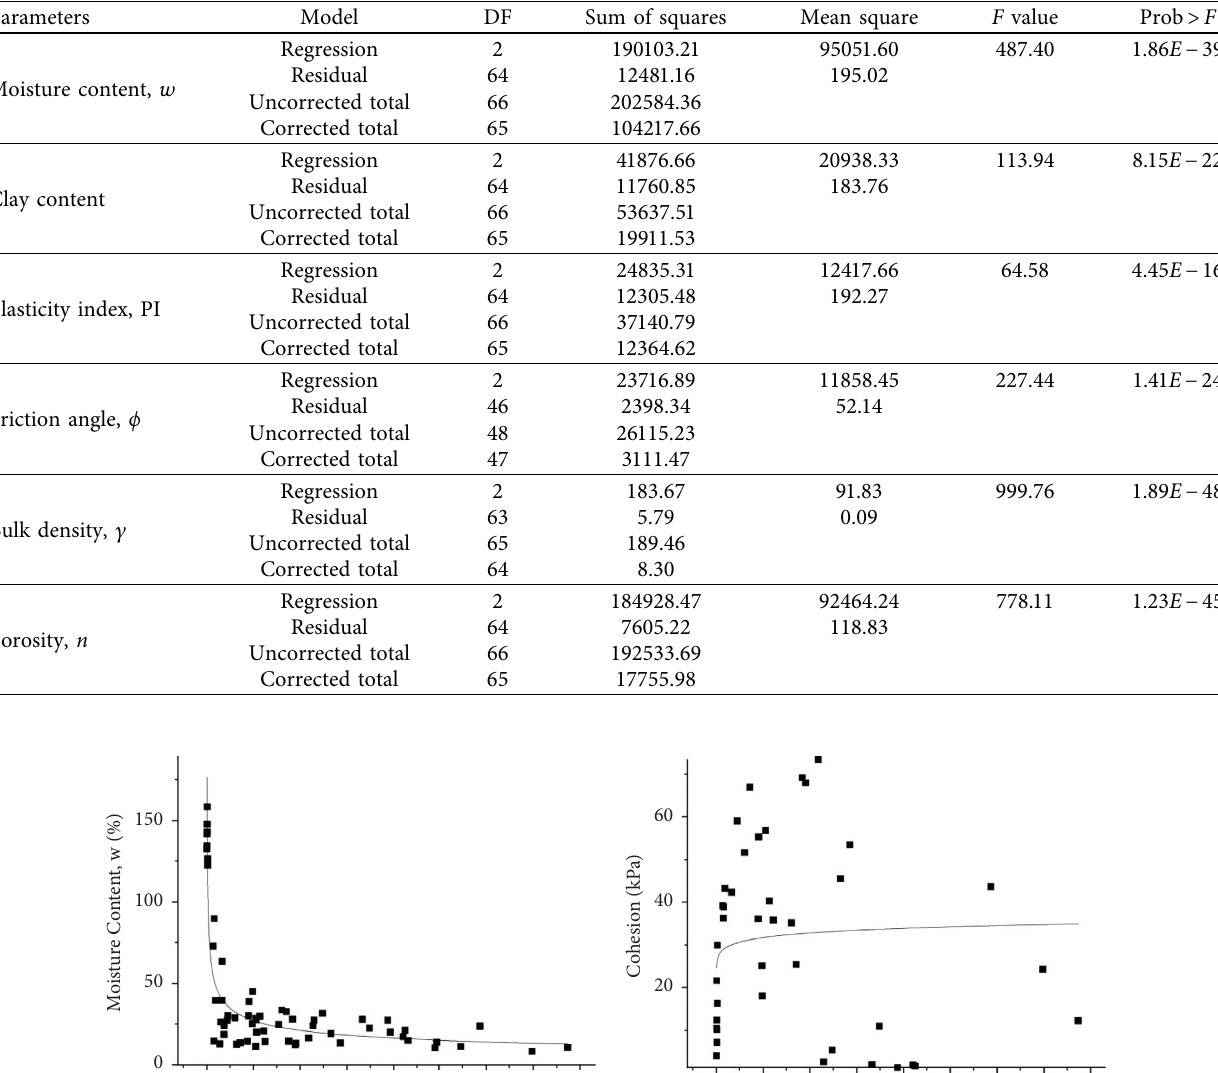
Table 3: Analysis of soil parameters using the ANOVA